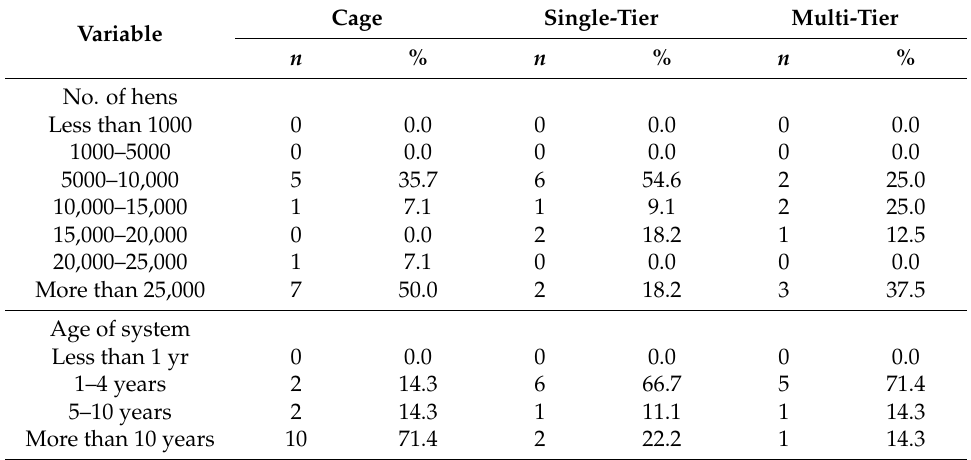
Table 1. A description of general farm characteristics for 33 pullet flocks placed between May